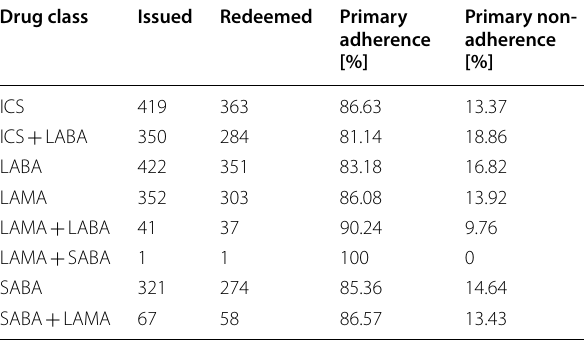
Table 3 Primary non-adherence for inhaled medication drug